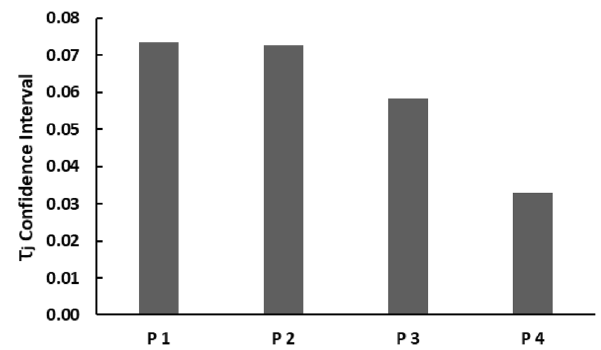
Fig. 8 95% confidence intervals on time constants ( 𝜏 j ) estimated by D-CRMP in case I. Subscript j stands for the producer index in the range 1 to